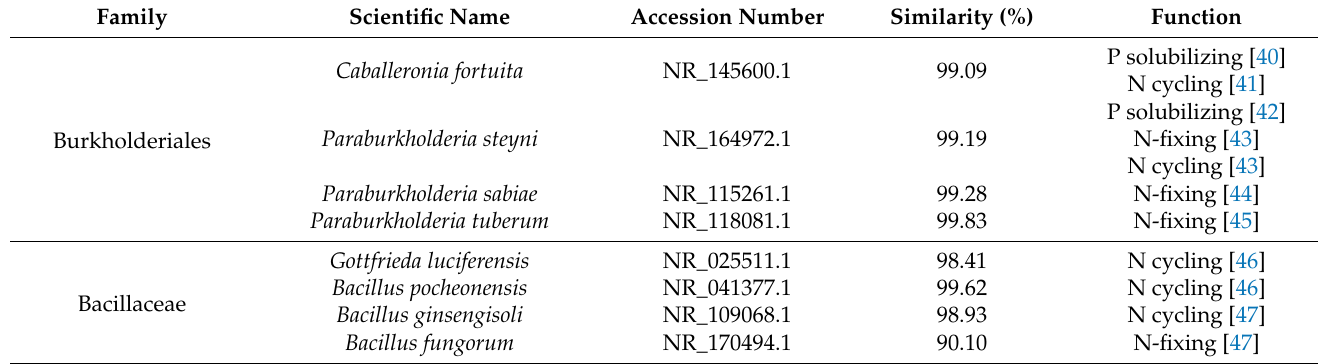
Table 3. Molecular identification of the bacterial community isolated from the E. natalensis